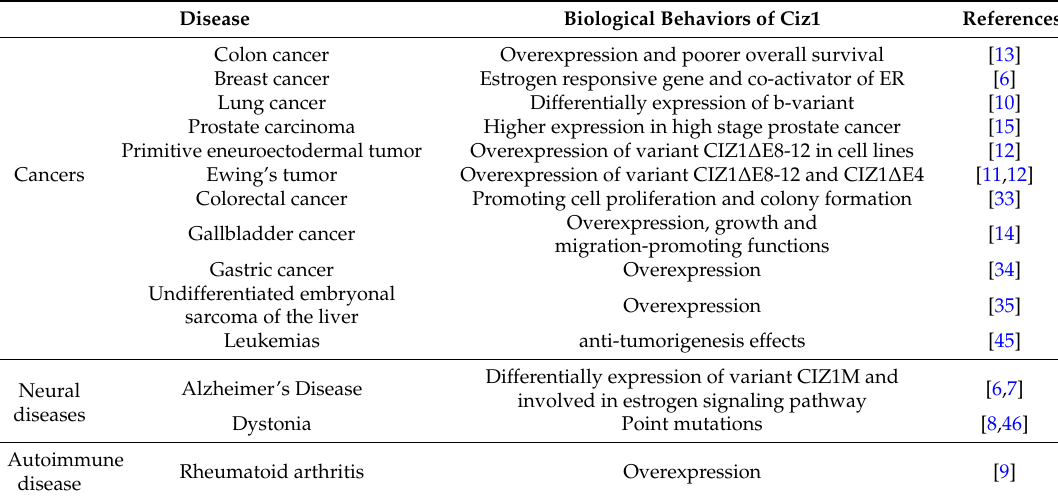
Table 2. CIZ1-related